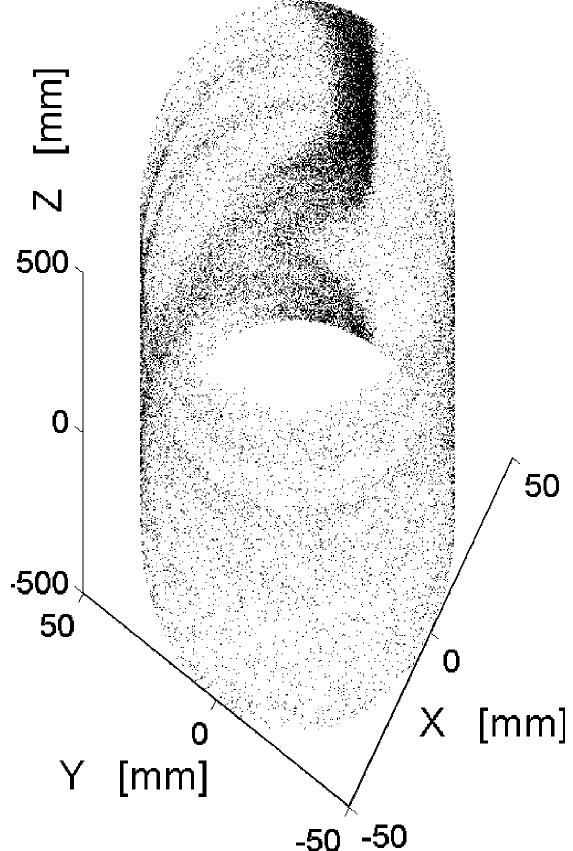
FIG. 6. Lost electron distribution around the chamber wall in the solenoid field with equal polarity